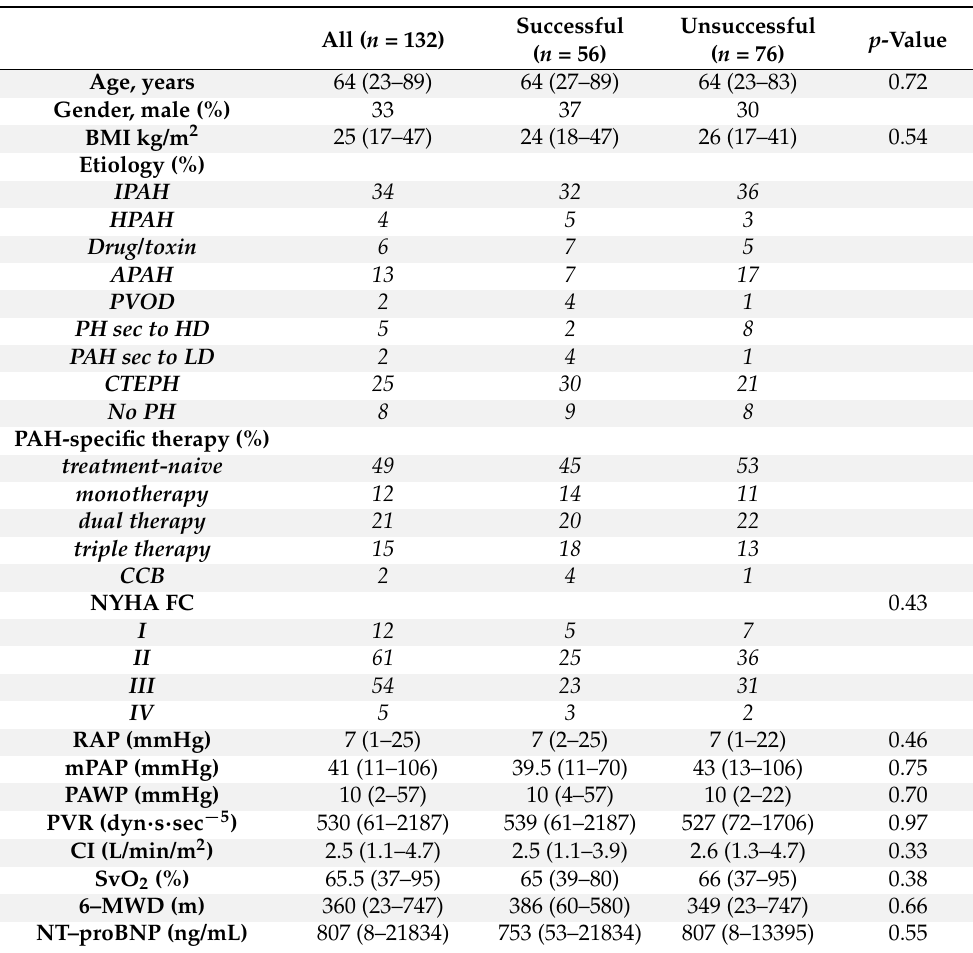
Table 1. Patient characteristics.